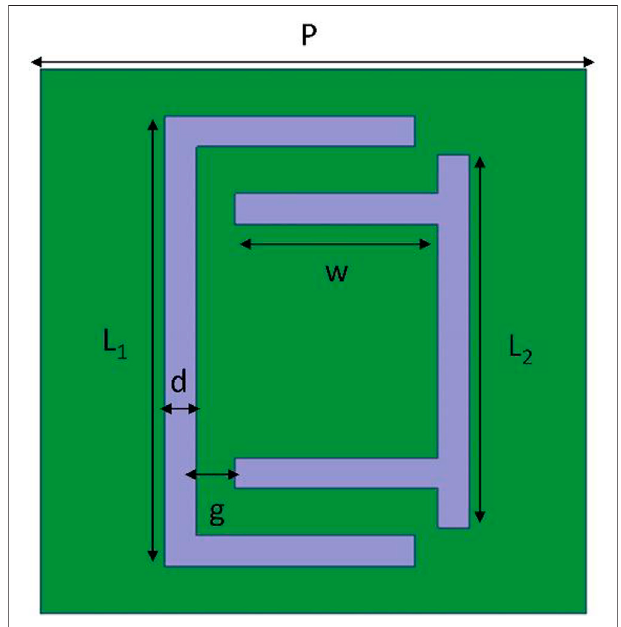
FIGURE 13 | Schematic of a metamaterial-based perfect